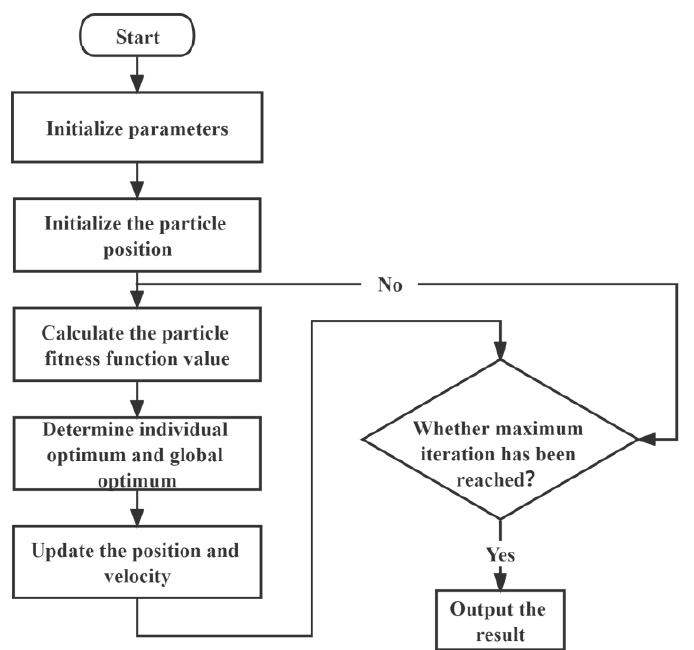
Figure 2. Flow chart of Particle Swarm Optimization [39].